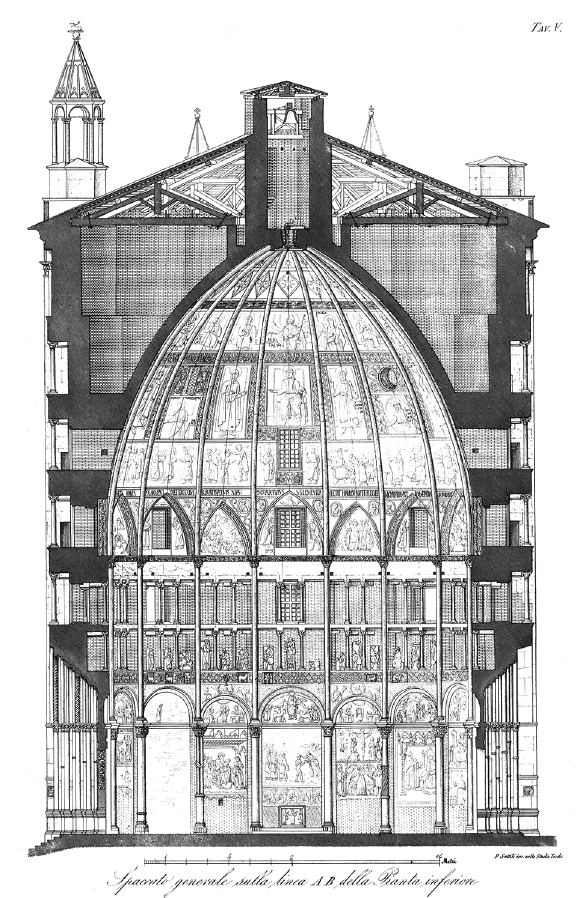
Figure 2. G. Bertoluzzi, P. Sottili: vertical section of the Parma baptistery